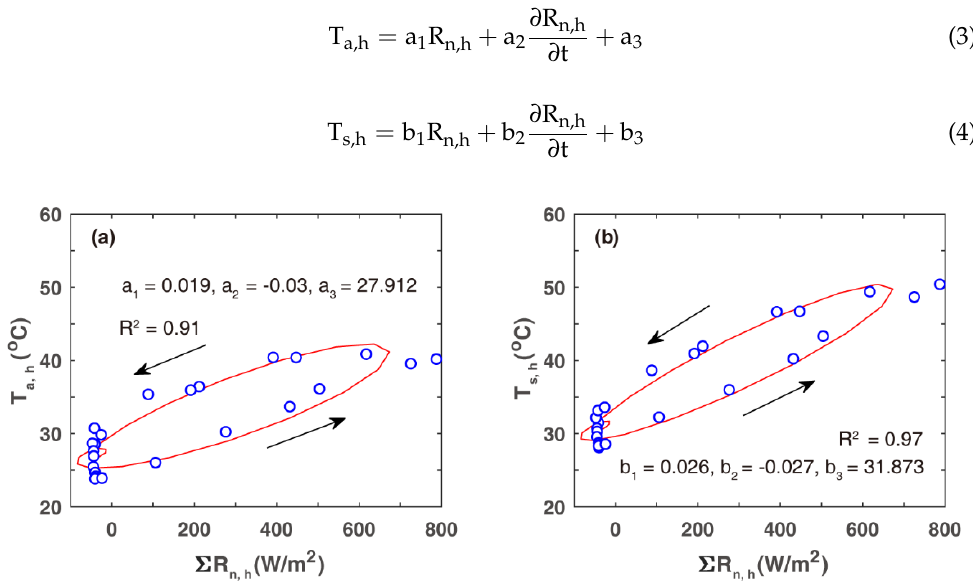
Figure 10. Lag effect between R n,h and T h on July 29. ( a ) R n,h and T a, h ; ( b ) R n,h and T s, h .